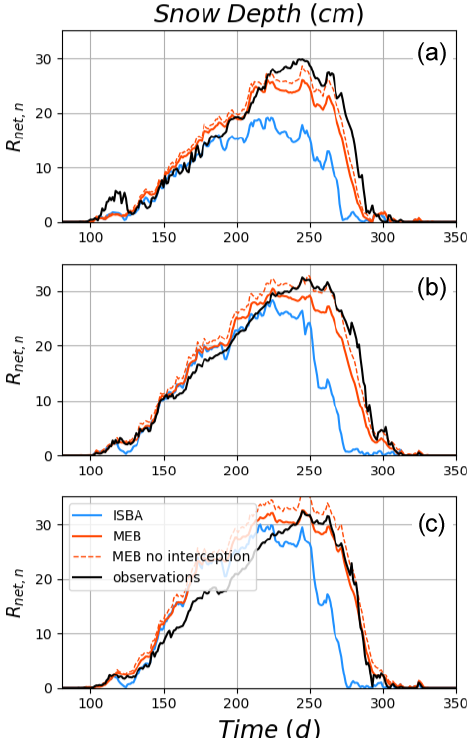
Figure 5. Composite of snow depth annual (July to June) cycles for the three sites: MEB is in red, ISBA is in blue, and observations are in black. The dashed red curve corresponds to a version of MEB with no snow interception by the